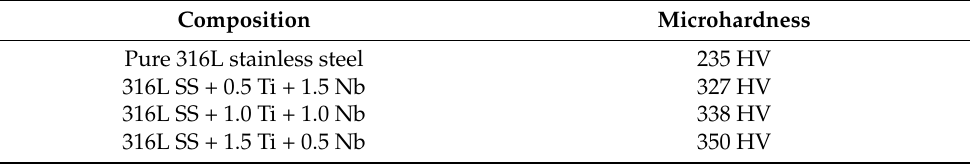
Table 5. Microhardness of sintered samples.